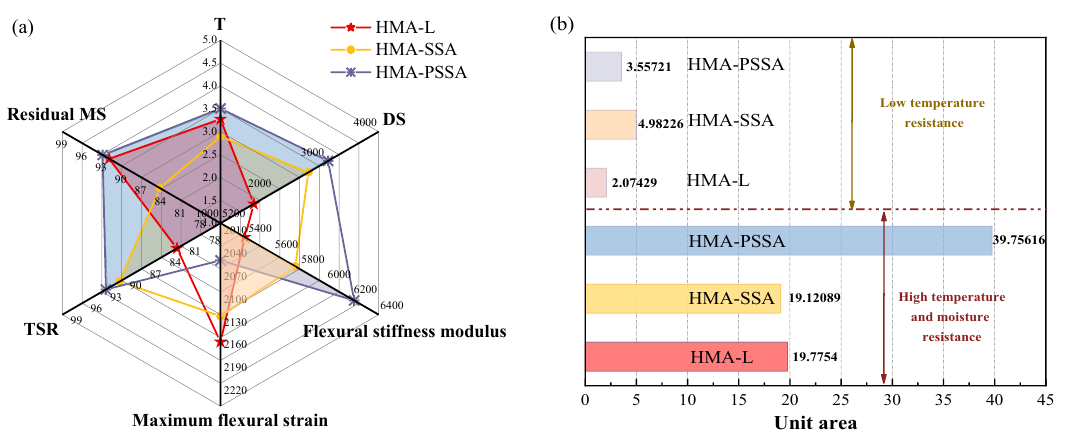
Figure 19. Comprehensive road performance of mixtures: ( a ) Coupling of road performance indica- tors; ( b ) Unit area.